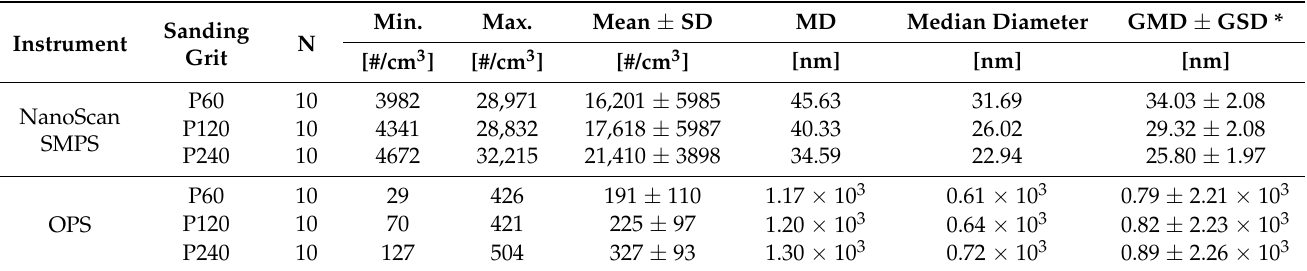
Table 1. Descriptive statistics of measured data by NanoScan SMPS and OPS.